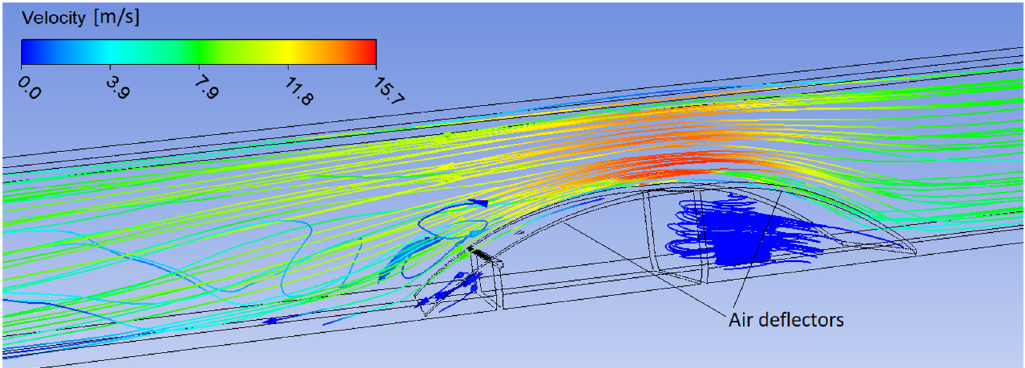
Figure 13. Streamlines; CFD model with a beam size of 288 mm with air deflectors upstream and downstream of the beam.